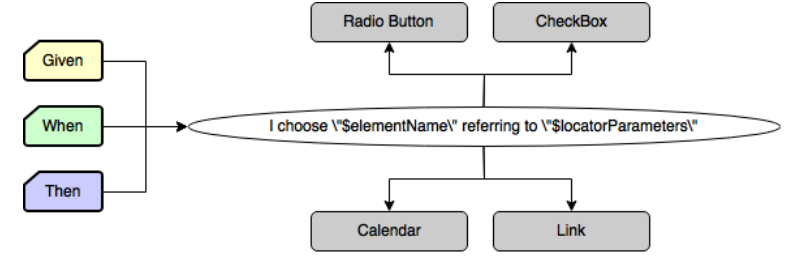
Figure 8. Behaviors being mapped to UI